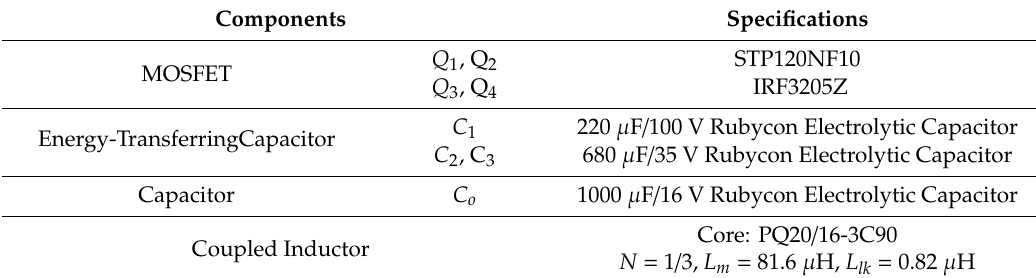
Table 4. Specifications of the components used in the proposed